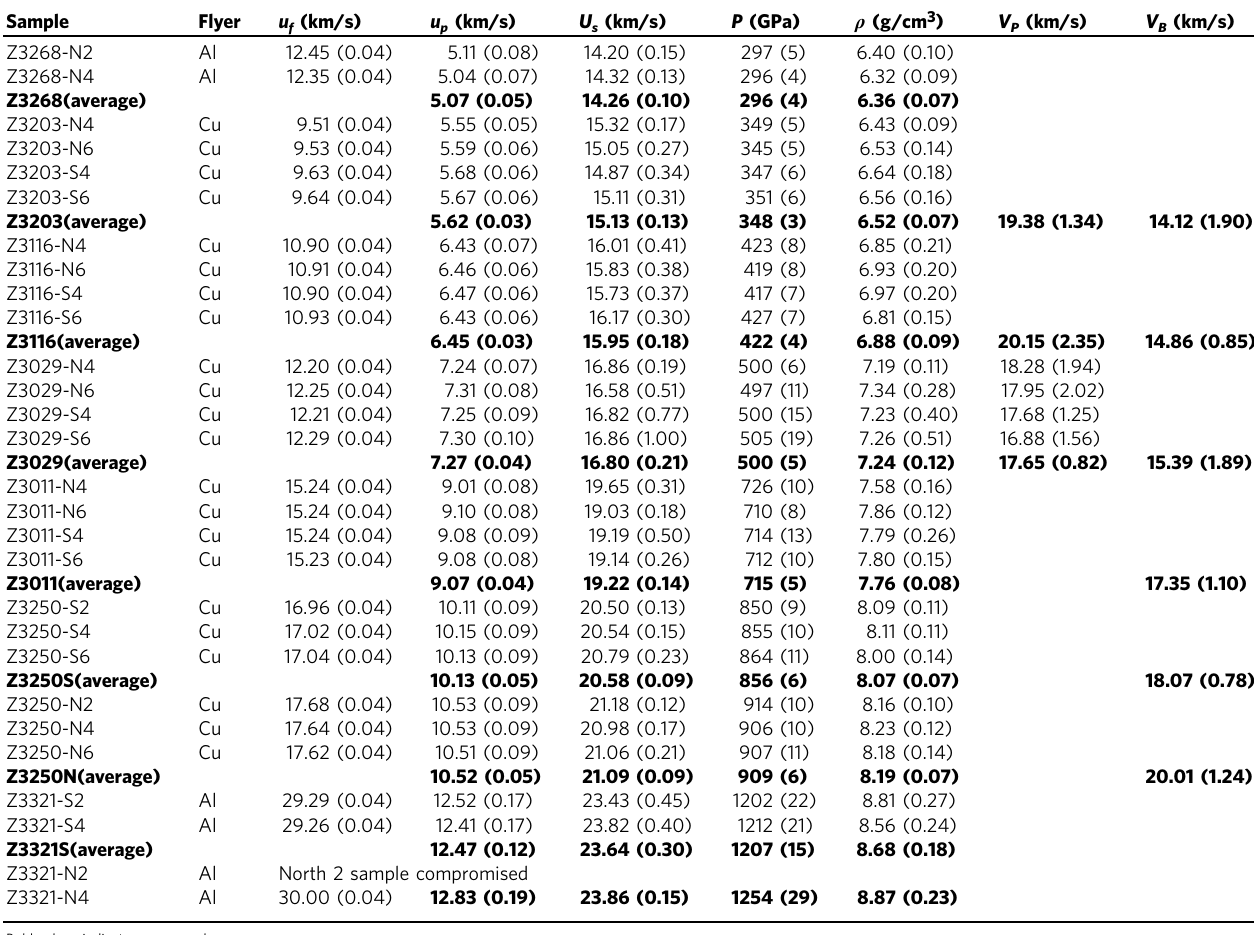
Bold values indicate average